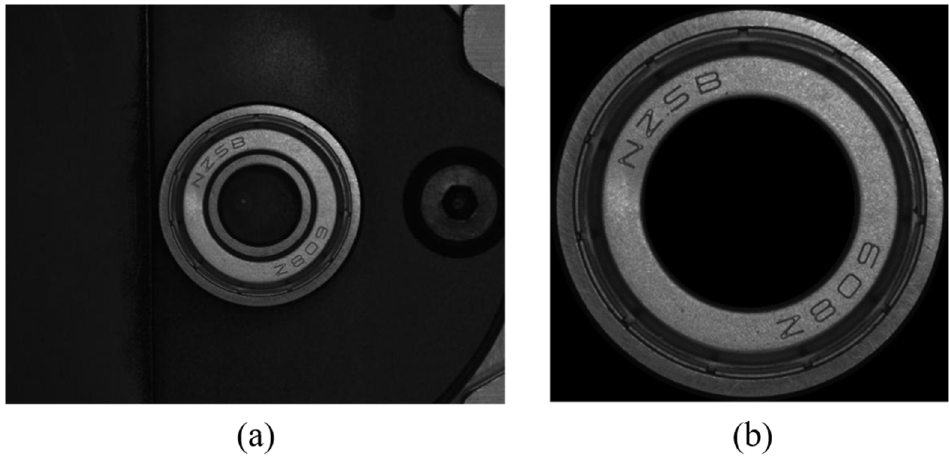
Figure 8. Data collected by the platform. ( a ) Original data ( b ) Bearing